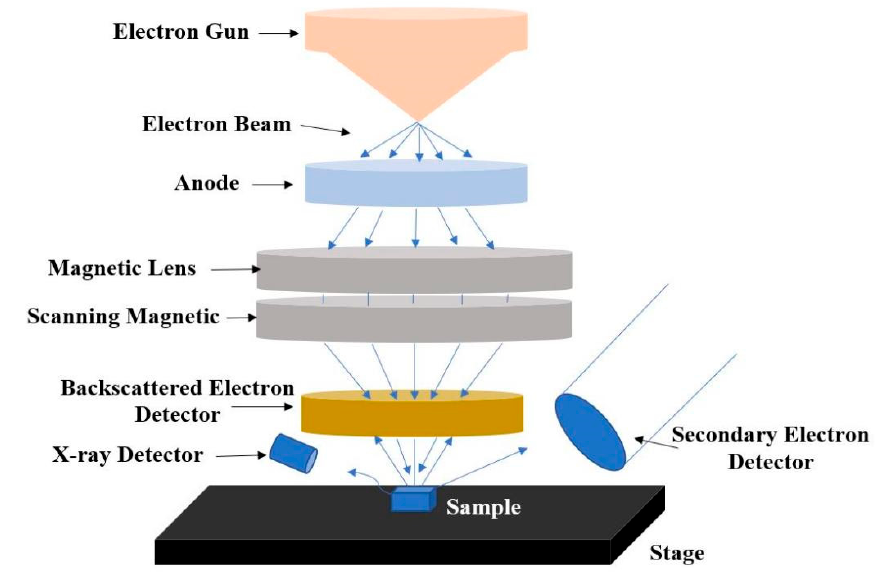
Figure 2. Schematic representation of a scanning electron